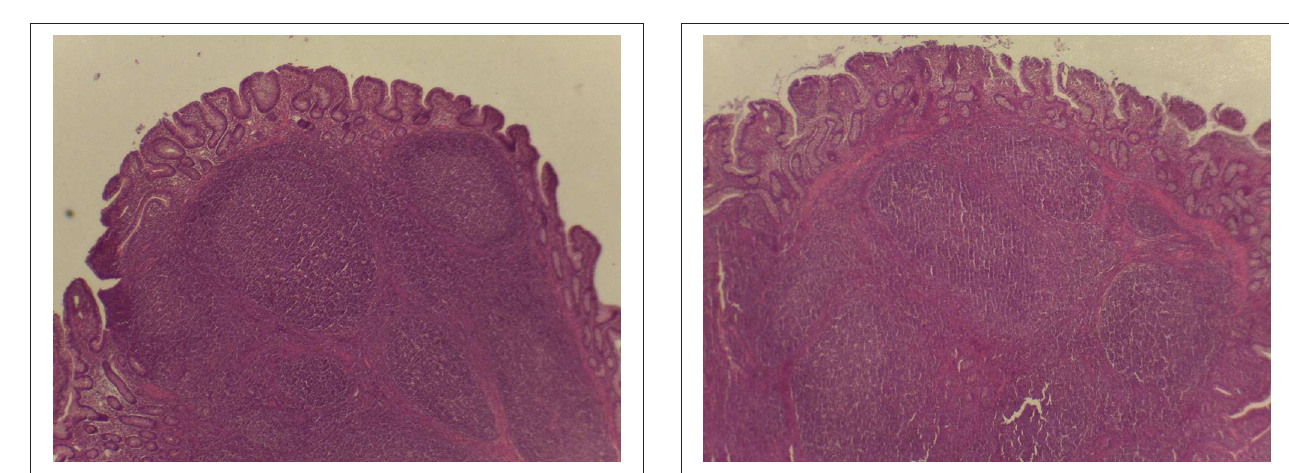
FIGURE 3 | Microscopy of PPs in pigs from the experimental group fed with the FP diet.